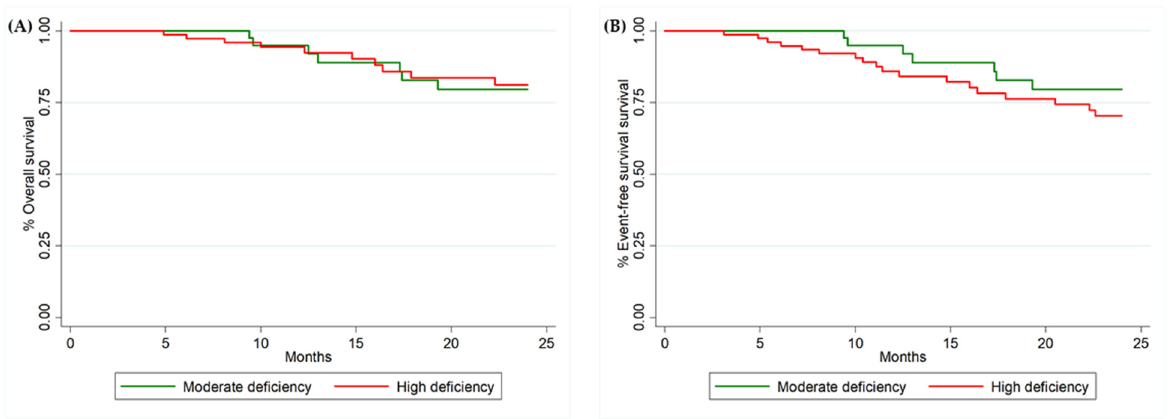
Figure 1. Kaplan–Meier curves for patients with HF considering ( A ) the overall survival and micronutrient deficiency groups and ( B ) event-free survival and micronutrient deficiency groups.